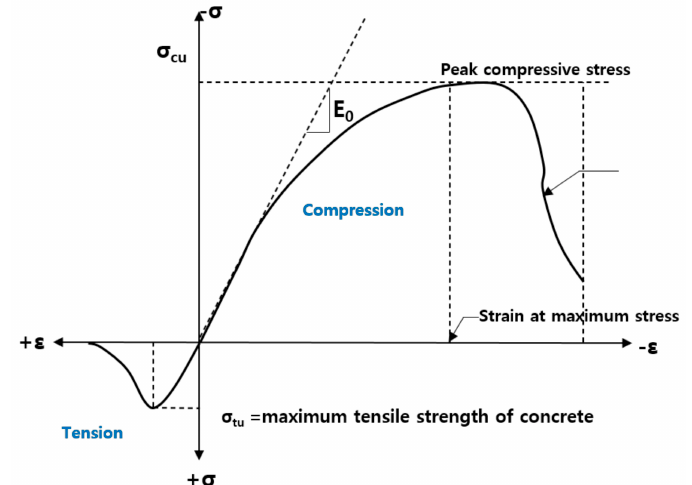
Figure 4. Typical uniaxial compression and tensile stress–strain curve for